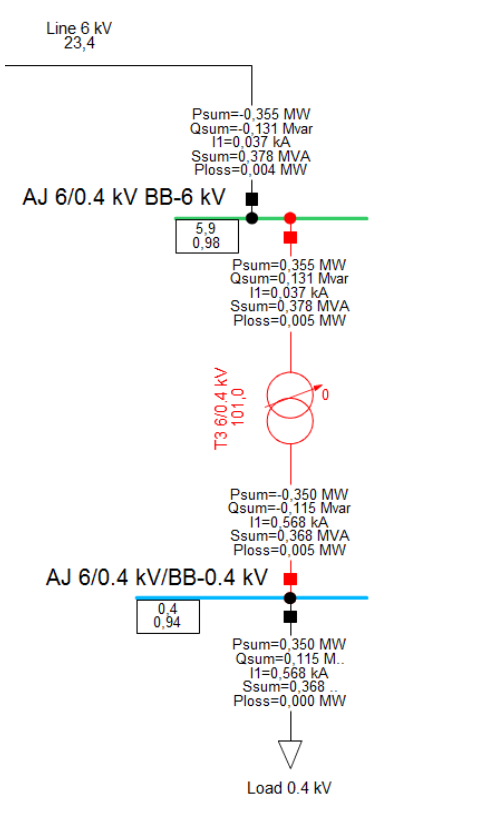
Fig. 4. PFS demonstrating the influence of reactive power on the equipment capacity.